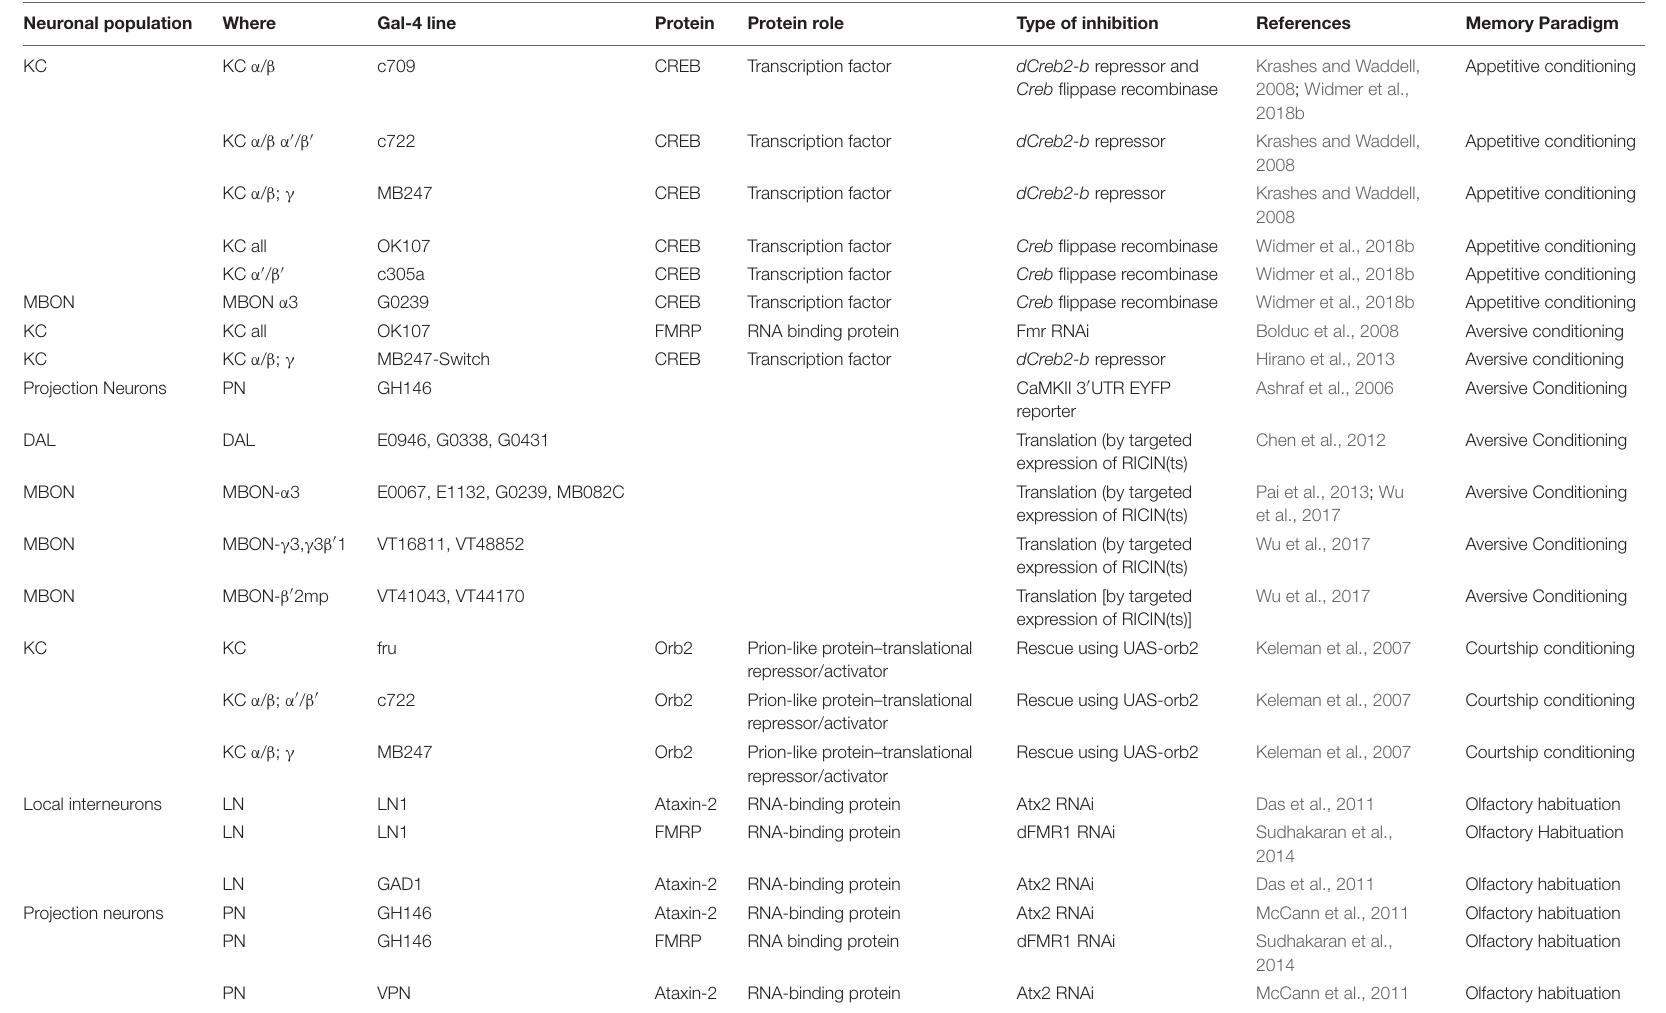
TABLE 2 | Neuronal subtypes in which translation has been shown to be specifically required for different types of long-term memory. Neuronal population